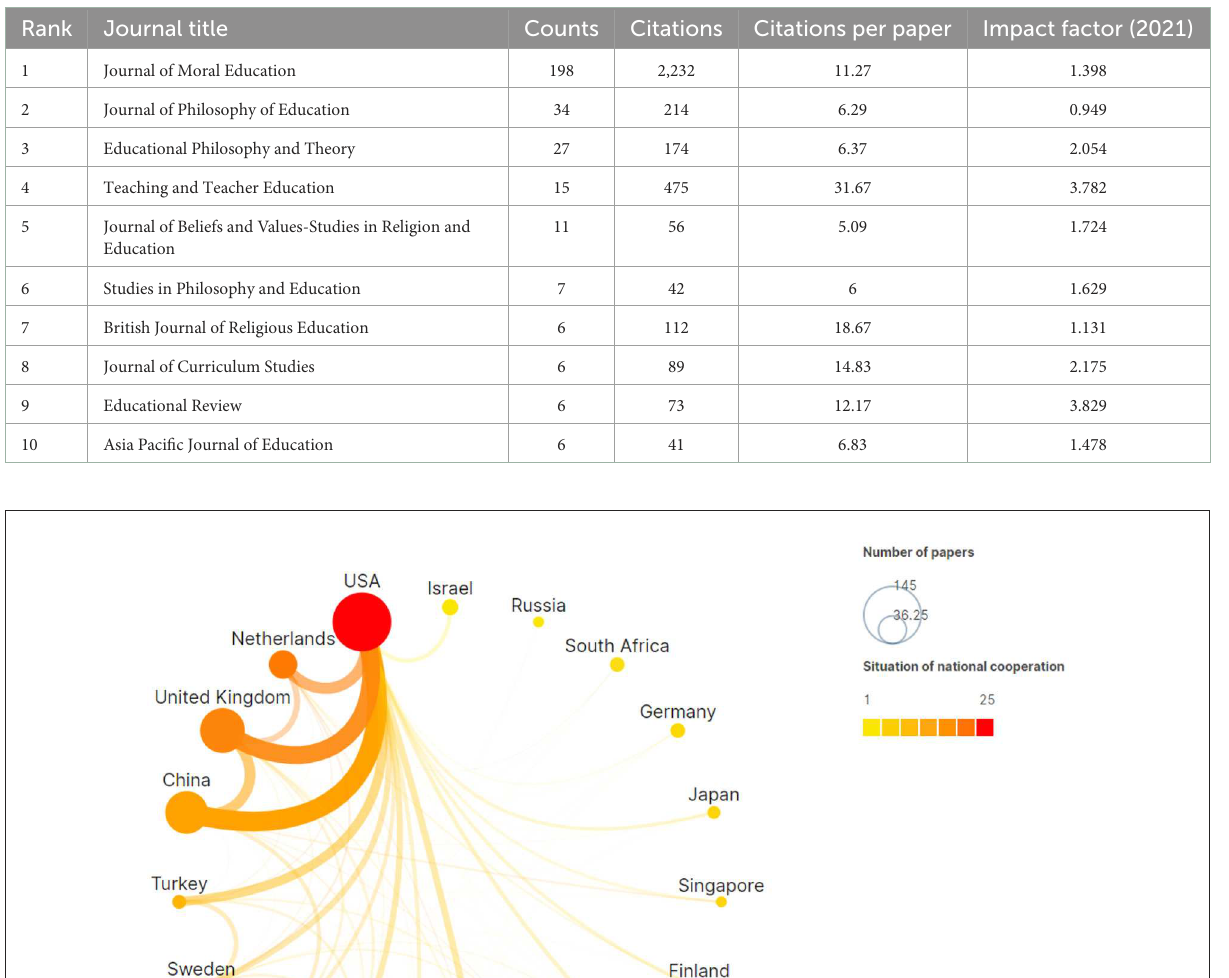
TABLE 3 Top 10 journals in the moral education research field.